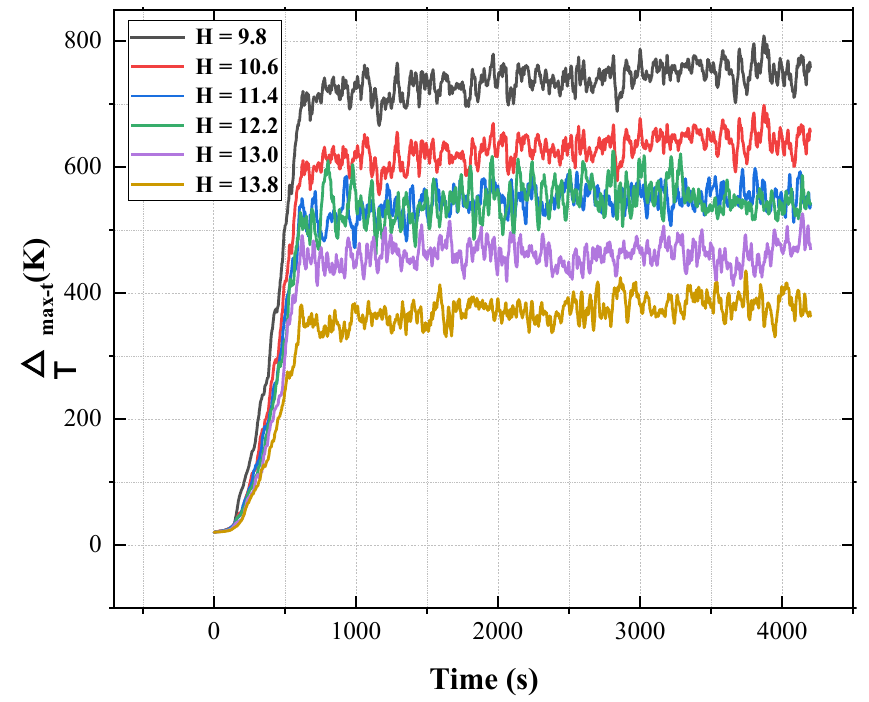
Figure 6. Maximum excess temperature of the truss versus time.